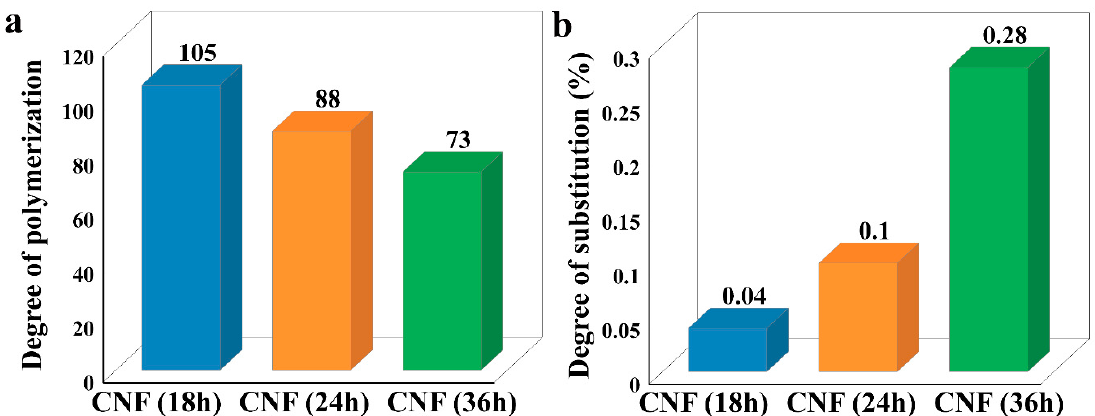
Figure 5. ( a ) Degree of polymerization (DP) of the cellulose in CNFs. ( b ) Degree of phosphorus substitution (DS) of the cellulose.